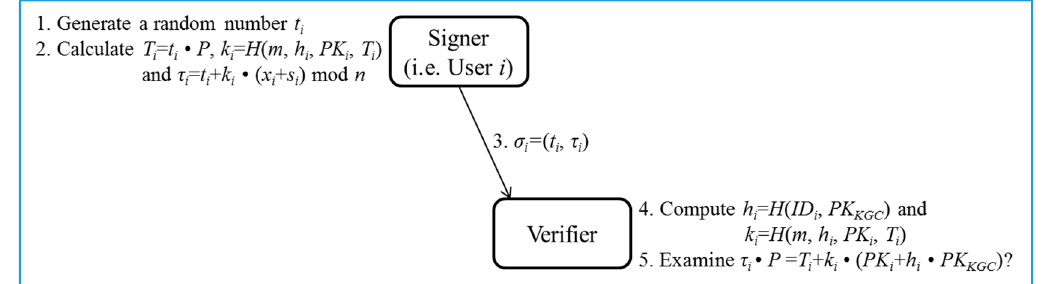
Figure 3. Sign/Verify phase of the proposed certificateless signature scheme.